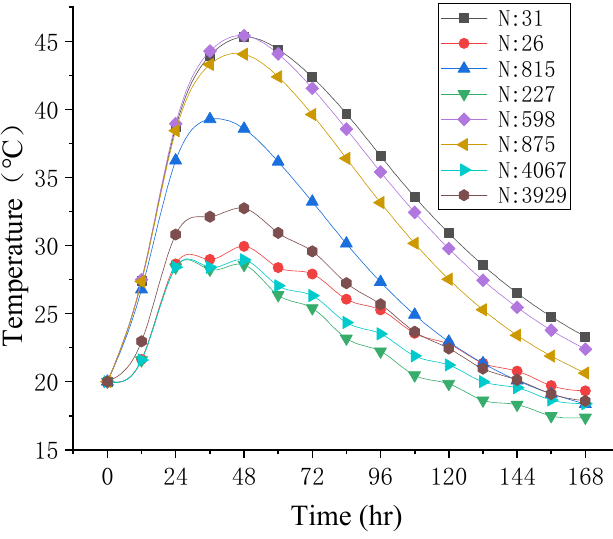
Figure 11. Time–temperature curves of each key node of the box girder.